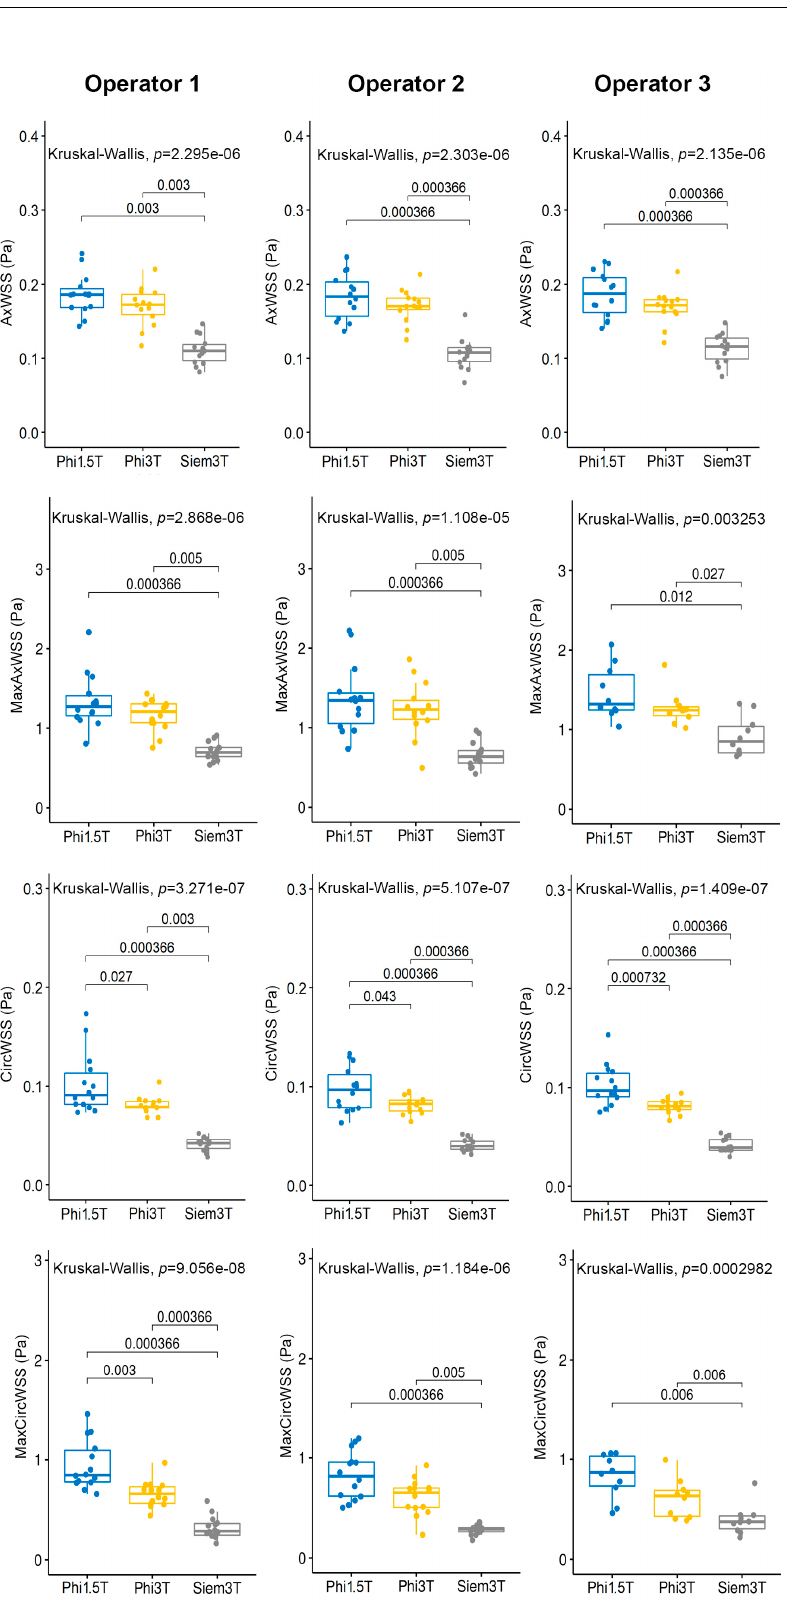
Figure 7. Inter-device agreement of AxWSS, MaxAxWSS, CircWSS and MaxCircWSS. For each parameter (AxWSS, MaxAxWSS, CircWSS, MaxCircWSS), boxplots of Kruskal–Wallis test show the comparison of measurements from 3 devices (Philips 1.5 T, Philips 3 T, and Siemens 3 T) using data by operator 1, operator 2 and operator